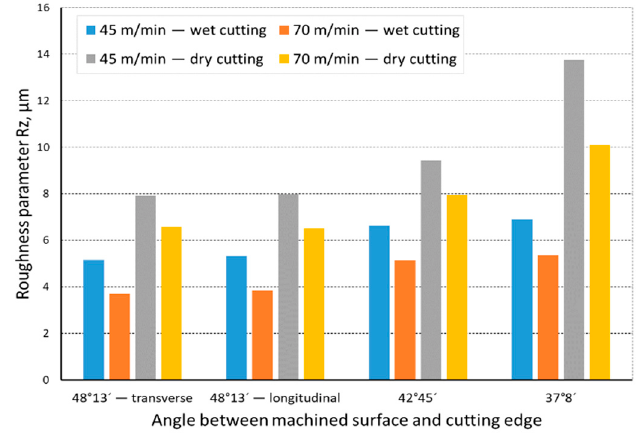
Figure 6. The impact of cutting speed on the variability of roughness parameter Rz in the function of the angle between the machined surface and cutting edge for a rectilinear track and a material hardness of 23 HRC.